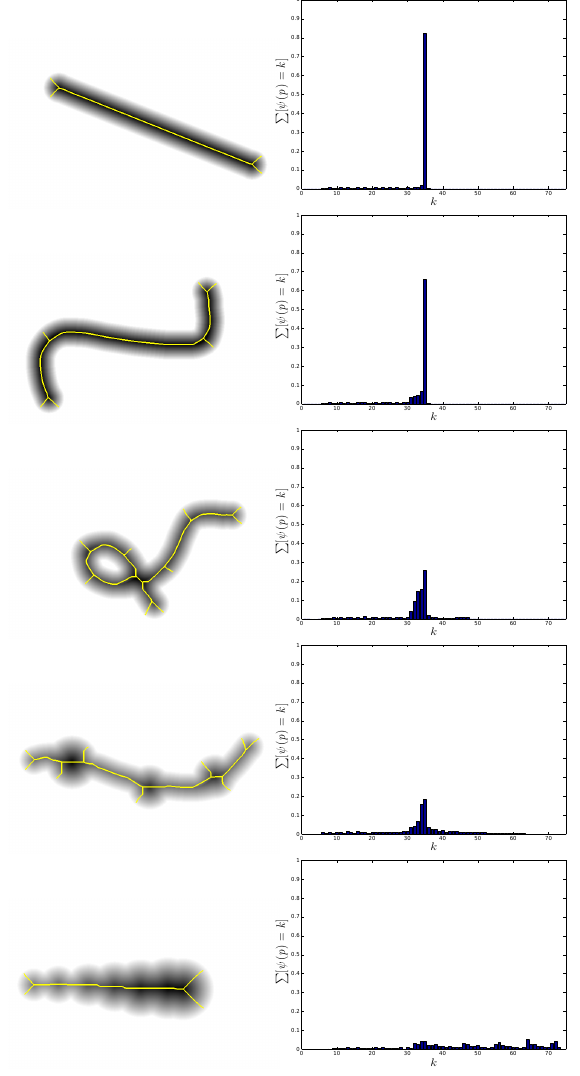
Figure 1: Histogram representation of synthetic objects without skeleton pruning. Left the medial axis superimposed on the object, and right, the object’s